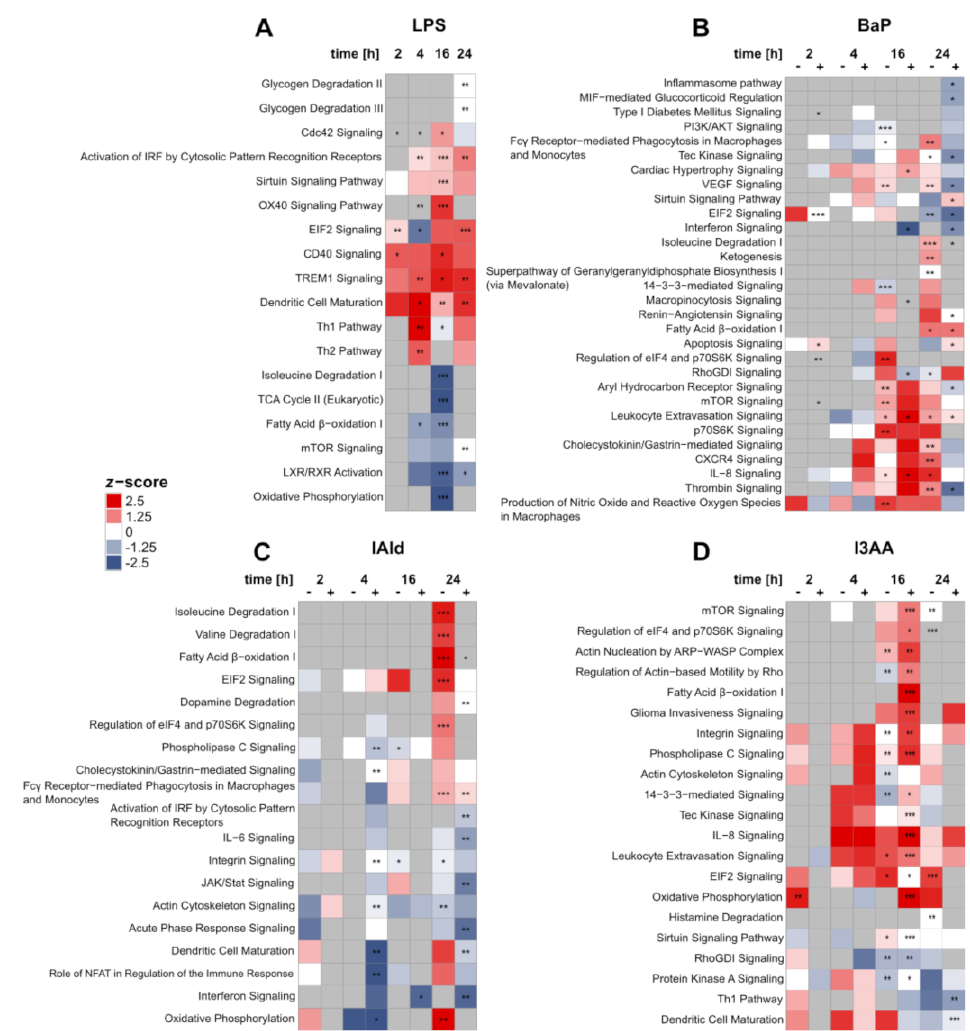
Figure 5. Changes in IPA core pathways over time after treatment with LPS ( A ), BaP ( B ), I3AA ( C ), and IAld ( D ), each with (+) or without (–) LPS co-stimulation and compared with the corresponding control samples (either with or without LPS). Regulation of pathways was identified by z -scores. Regulated pathways were marked either red (up, z -score > 0) or blue (down, z -score < 0). The significance of enrichment was determined by Fisher’s Exact t -test, Benjamini-Hochberg adjusted, and indicated with asterisks: adjusted p -value ≤ 0.05 (*); adjusted p -value ≤ 0.01 (**); adjusted p -value ≤ 0.001 (***) ( n = 6 for 2 h and 4 h, n = 5 for 16 h and 24